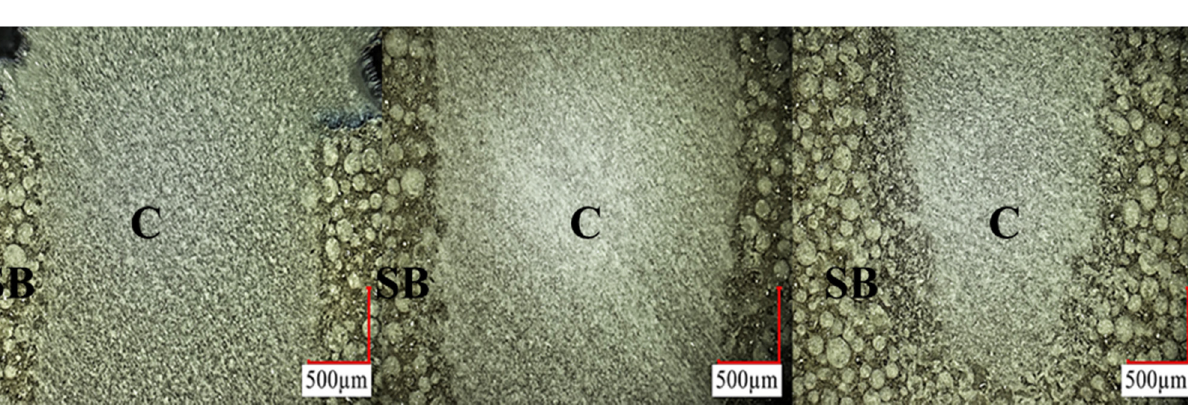
Figure 3. Flow and sealing effectiveness of the CBS 50 (40% filled) cement. The figure illustrates the material fully sealing a Sawbones ® defect of interest (2 mm × 10 mm) without leaving gaps along the interface using a rigid polyurethane foam model. The panels are arranged in order of increasing depth into the defect from left to right. No pressurization was necessary for the material to fill down toward the bottom of the defect. “SB” denotes Sawbones ® , and “C” denoted